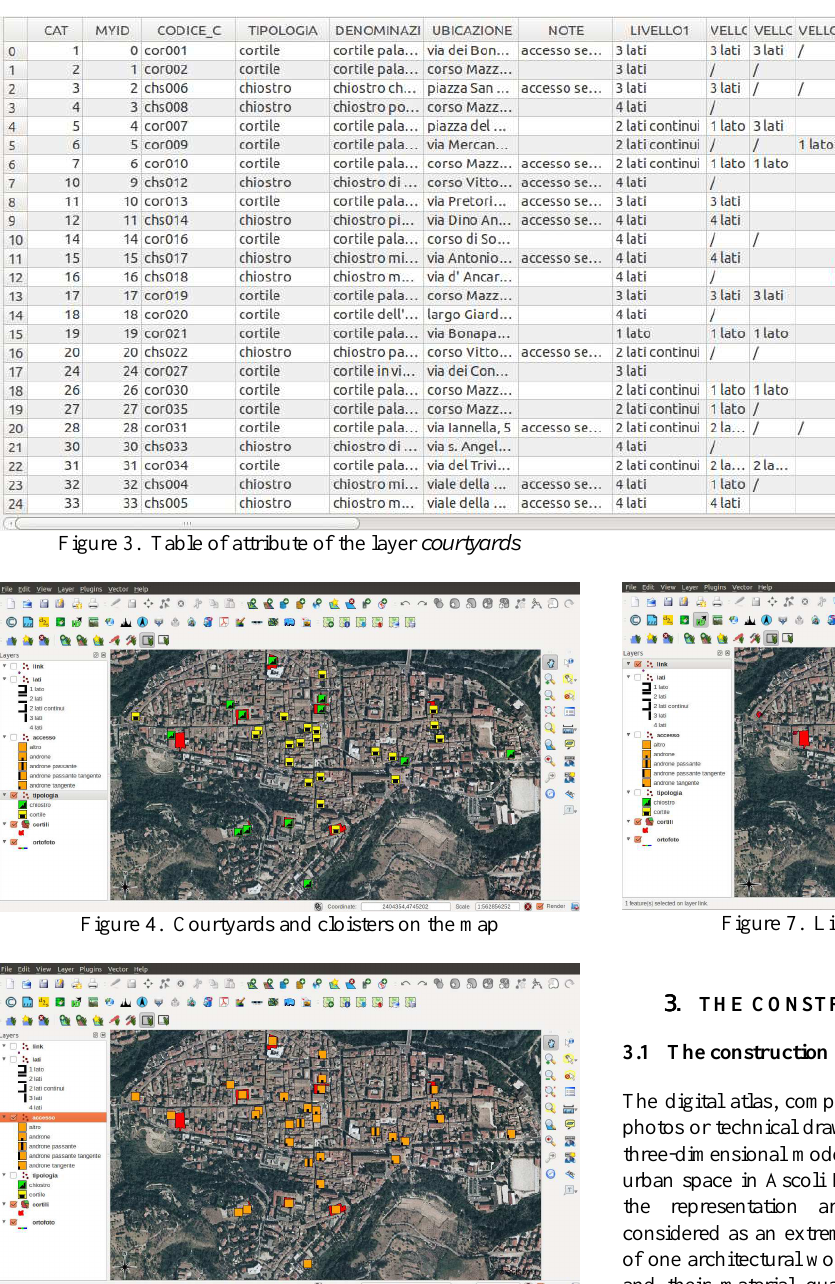
Figure 5. Icons to identify the type of access